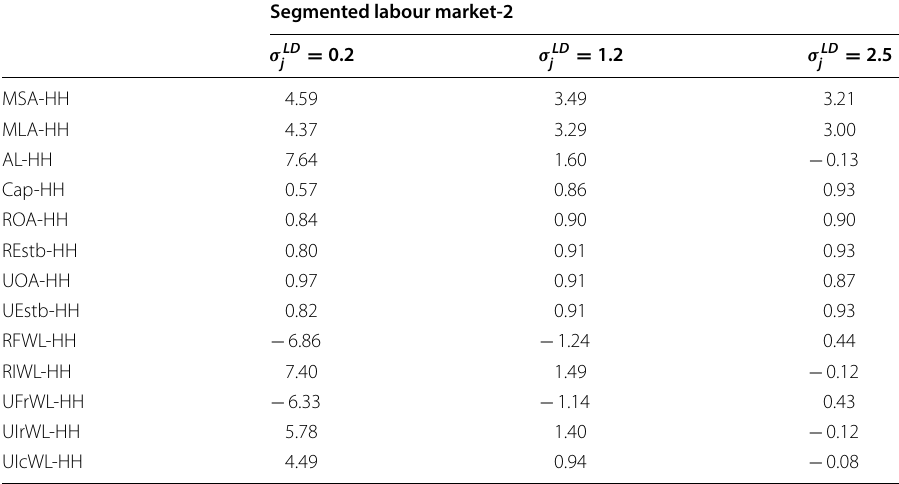
Table 13 (Scenario A3:S1–S3) Observed change (%) in total income of households due to 50% tariff cut